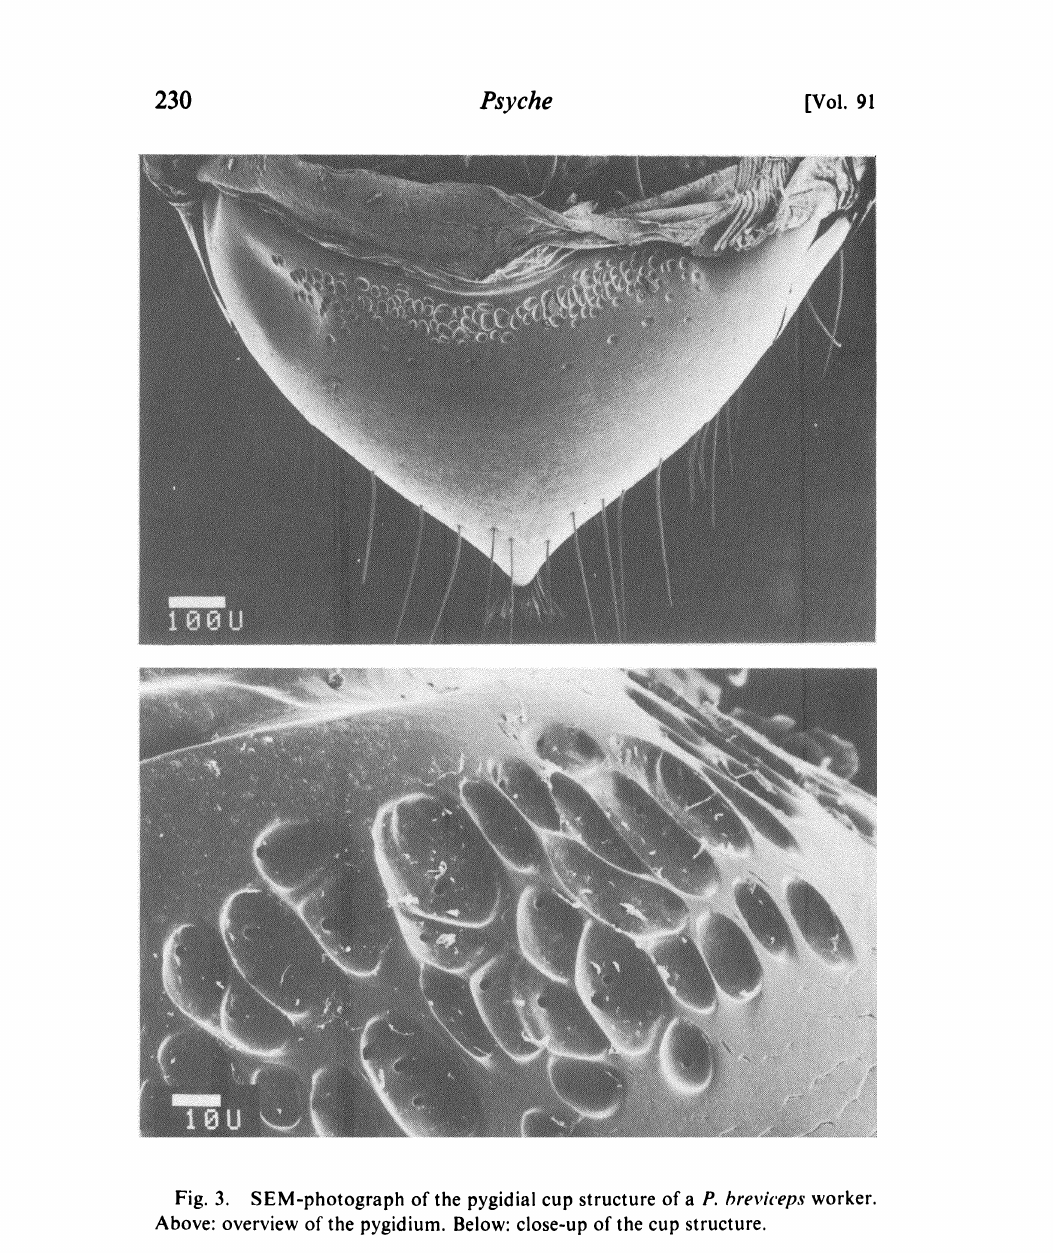
Fig. 3. SEM-photograph of the pygidial cup structure of a P. breviceps worker. Above: overview of the pygidium. Below: close-up of the cup